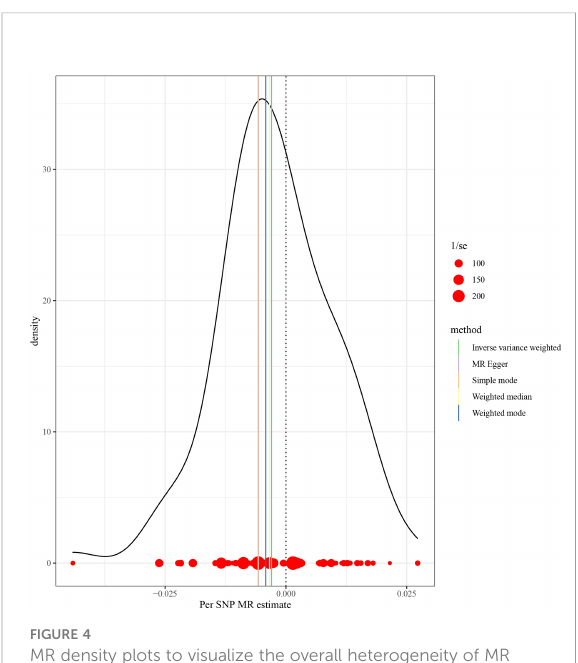
FIGURE 4 MR density plots to visualize the overall heterogeneity of MR estimates for the effect of Hypothyroidism on HCC. MR, Mendelian randomization; SNP, single-nucleotide polymorphism; HCC, Hepatocellular